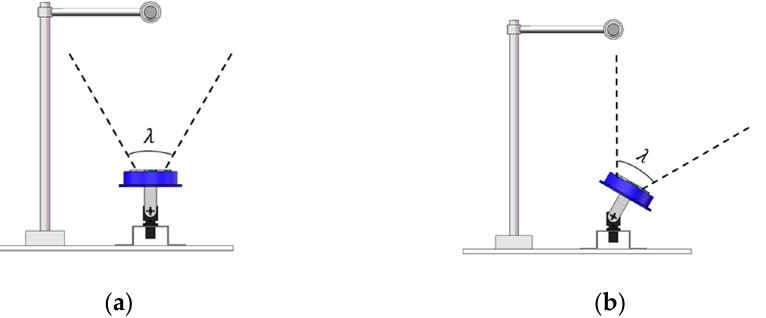
Figure 21. Schematic diagram of the FOV experiment. ( a ) The steering gear pan tilt was used to level the center sensor. ( b ) Using a rotation angle of ϕ i for the steering gear pan tilt, the heat source was imaged at the edge of the FOV.